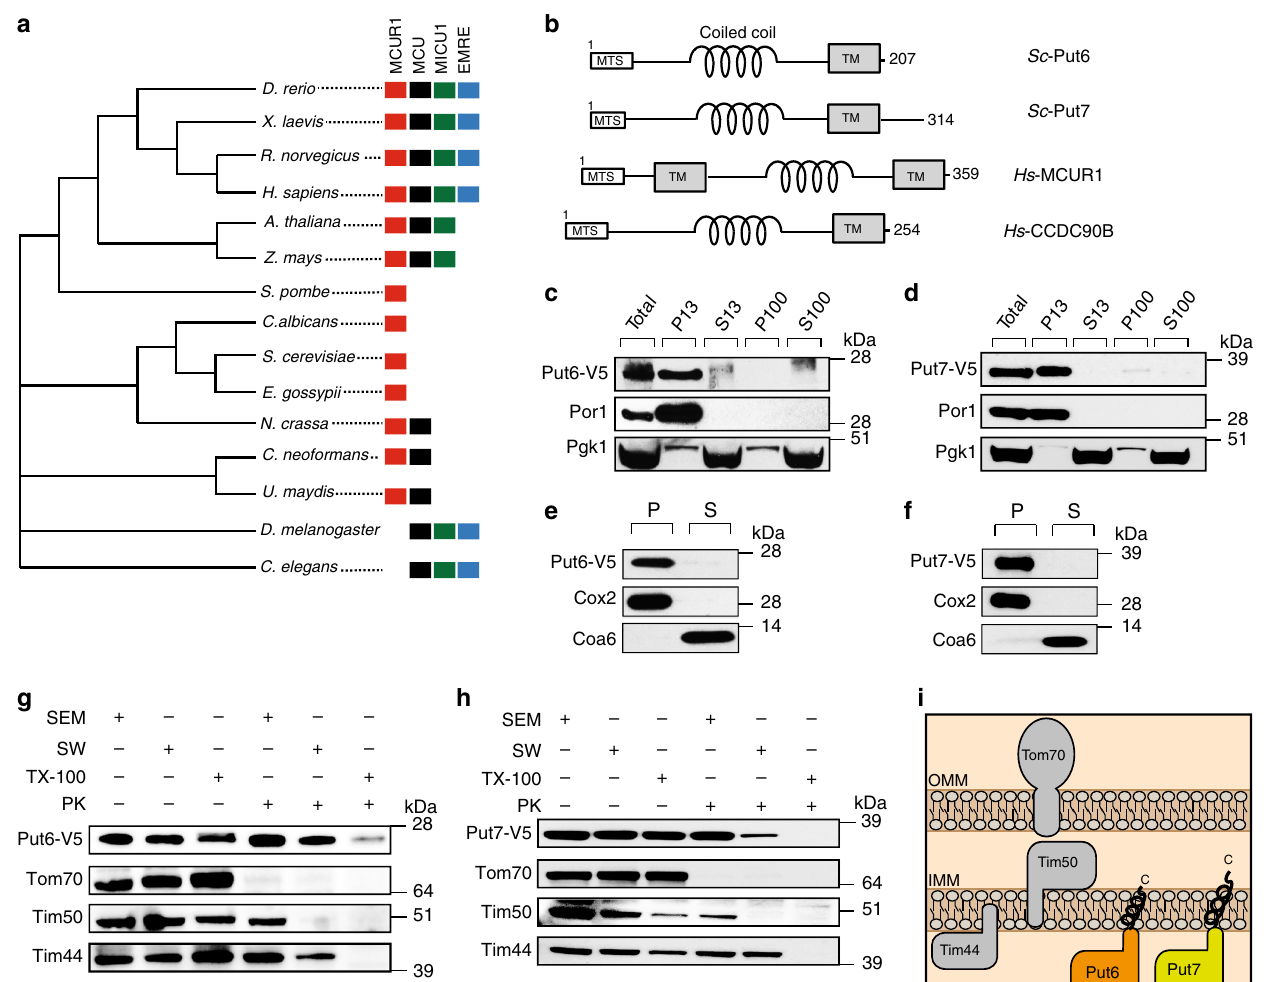
Fig. 1 Phylogeny, localization and topology of Put6 and Put7. a Phylogenetic tree focused on 15 selected species across different eukaryotic phyla showing the presence of MCUR1 and mitochondrial Ca 2 + uniporter components MCU, MICU1, and EMRE. b Schematic showing predicted domain organization of Put6, Put7, MCUR1, and CCDC90B proteins. MTS, mitochondria targeting sequence; TM, transmembrane helix; Sc , Saccharomyces cerevisiae ; Hs , Homo sapiens . c , d Put6 and Put7 are localized to the mitochondrial fraction. SDS-PAGE immunoblot analysis of different subcellular fractions prepared from Put6-V5 and Put7-V5 expressing cells. Por1 and Pgk1 were used as mitochondrial and cytosolic markers, respectively. Whole-cell protein lysate is depicted as “ Total ” , P and S refer to pellet and supernatant, respectively, and the number following P and S refers to the centrifugation speed × 1000 g . Data are representative of two independent experiments. e , f Put6 and Put7 are integral membrane proteins. Mitochondria containing Put6-V5 and Put7-V5 were exposed to alkaline treatment at pH 11.5. Membrane integrated (P, pellet) and soluble (S) material were separated by centrifugation and analyzed by immunoblotting. Cox2 and Coa6 were used as markers for integral membrane and soluble proteins, respectively. Data are representative of two independent experiments. g , h N-terminal soluble domains of Put6 and Put7 are matrix facing. Mitochondria expressing Put6-V5 and Put7-V5 were resuspended in isotonic (SEM), hypotonic-swelling (SW), and Triton X-100 (TX-100)-containing buffer and were treated with ( + ) or without ( − ) proteinase K (PK). After 30 min incubation, samples were analyzed by immunoblotting using antibodies against V5 and the marker proteins, Tom70 (OMM), Tim50 (IMS), and Tim44 (matrix). Data are representative of three independent experiments. i Model showing the localization and topology of Put6 and Put7 proteins. OMM, outer mitochondrial membrane; IMM, inner mitochondrial membrane. Source data are provided as a Source data fi